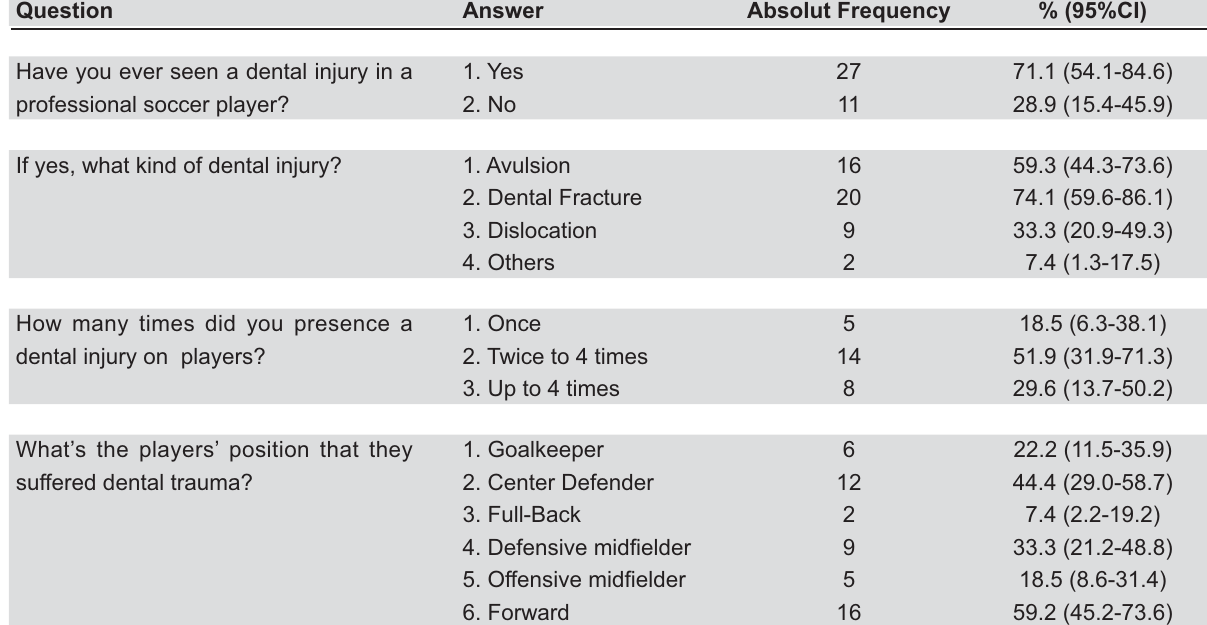
Table 1- Absolute and relative frequencies of dental trauma’s occurrence-based questions in Brazilians soccer clubs,